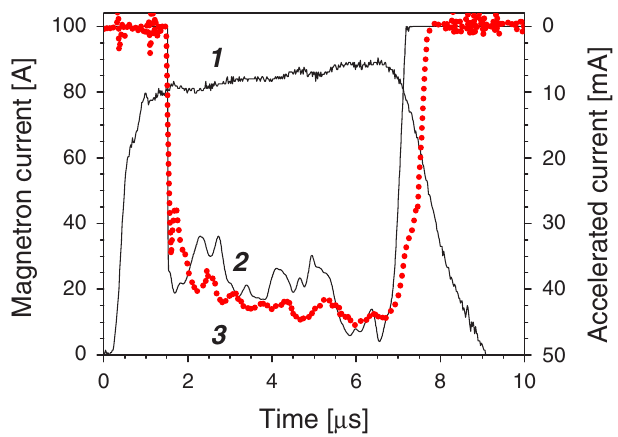
FIG. 5. (Color) Calculated, curve 2, relative units, and mea- sured, curve 3, right scale, accelerated current at the 12th orbit vs the incremental magnetron current, curve 1, left scale.